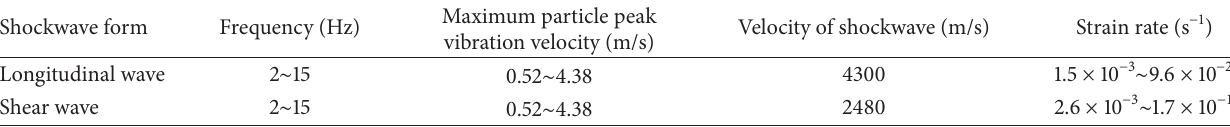
Table 2: Range of rock burst induced dynamic load strain rate.